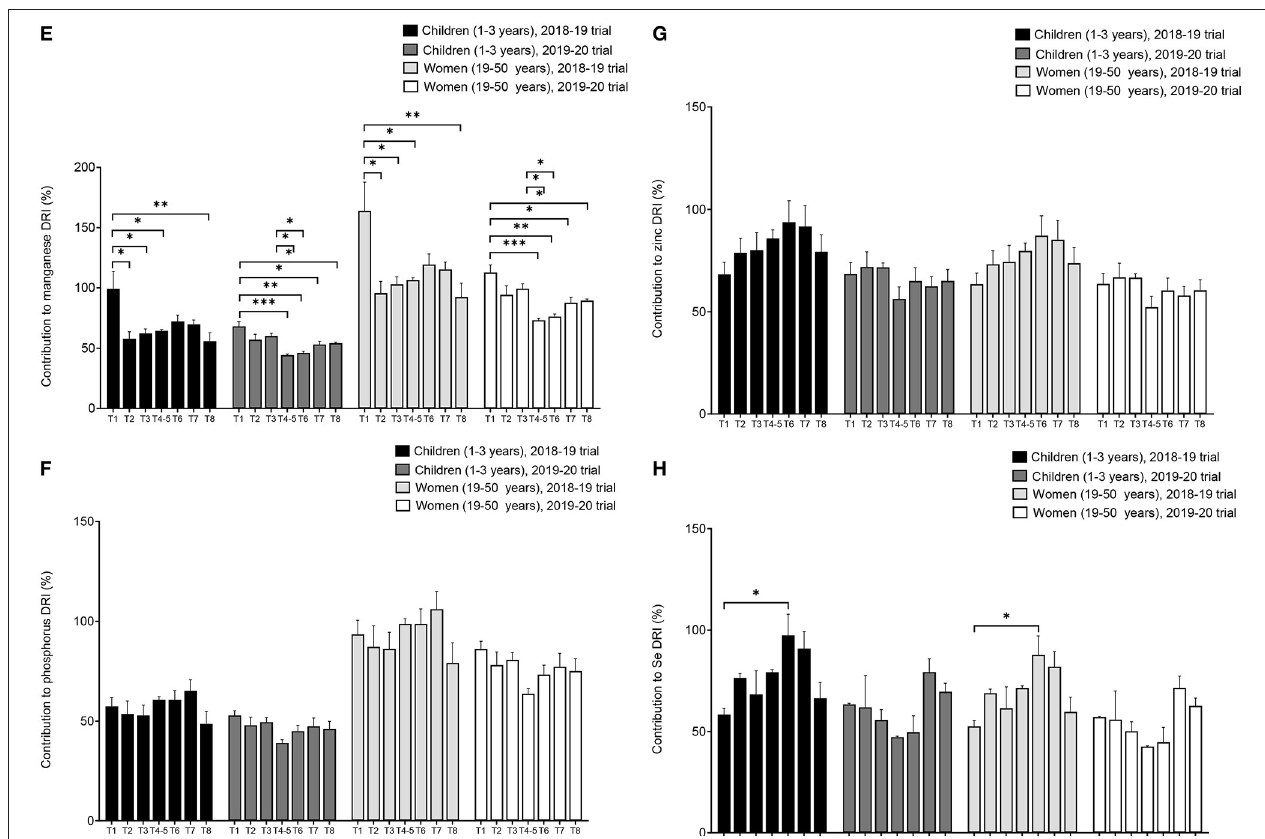
FIGURE 9 | Effect of conservation agriculture on the contribution of maize variety DKC 9089 to the nutrient dietary reference intakes of Malawian children and women. Error bars represent SEM. *, **, and *** mean, significant at 0.05, 0.01, and 0.001, respectively, Tukey’s HSD test. Treatments: T1 = conventional agriculture; sole maize. T2 = conservation agriculture (CA); basin sowing; sole maize. T3 = CA; dibble stick sowing; sole maize. T4–5 = CA; dibble stick sowing; maize-cowpea rotation. T6 = CA; dibble stick sowing; maize-pigeon pea intercrop. T7 = CA; dibble stick sowing; maize-cowpea intercrop. T8 = CA; dibble stick sowing; maize-velvet bean intercrop. DRIs, dietary reference